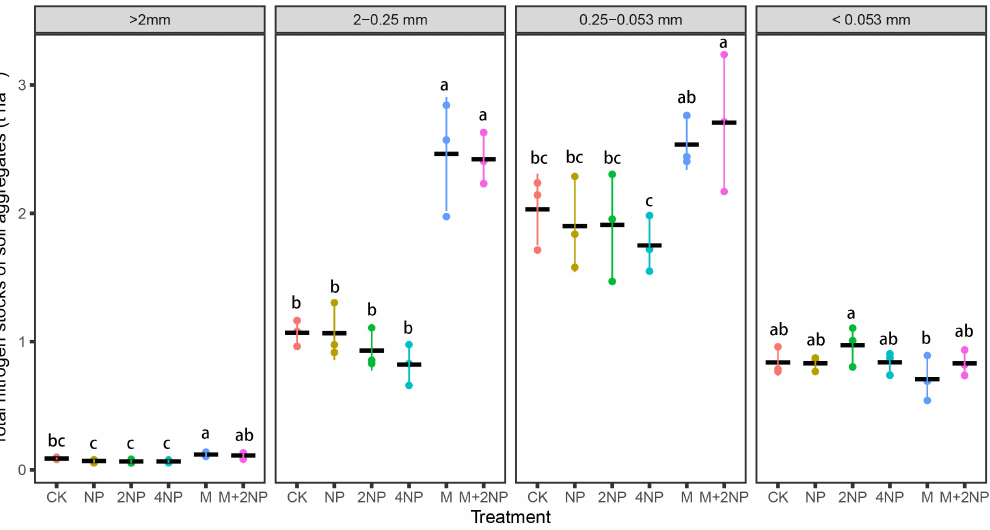
Figure 6. Total nitrogen stocks of soil aggregates. The black horizontal and colorful vertical lines represent the mean and SD, respectively, and the dots next to them represent the respective measured values. Different lowercase letters show significant differences among fertilization treatments in the same aggregate fractions ( p < 0.05). Values are given as means ± SD (n = 3). Abbreviations: CK = no fertilizer; NP = low−dose chemical fertilizer; 2NP = moderate−dose chemical fertilizer; 4NP = high−dose chemical fertilizer; M = normal−dose organic fertilizer; M+2NP = normal−dose organic fertilizer + moderate−dose chemical fertilizer.